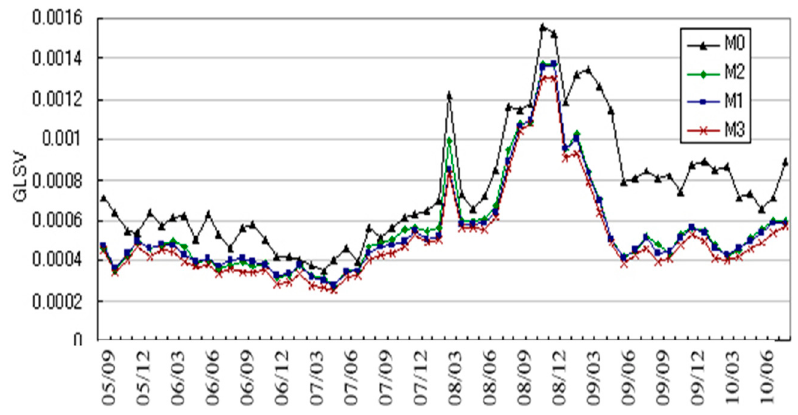
Figure 1. Generalized least squares variations (GLSVs) defined by ( ˆ ψ / G ) 1/2 plotted over the period September 2005 to August 2010 (end-of-month analysis) (Kariya et al. 2012). Table 1. Average residual standard deviations (RSDs) of M3 and M0 models (in yen). I